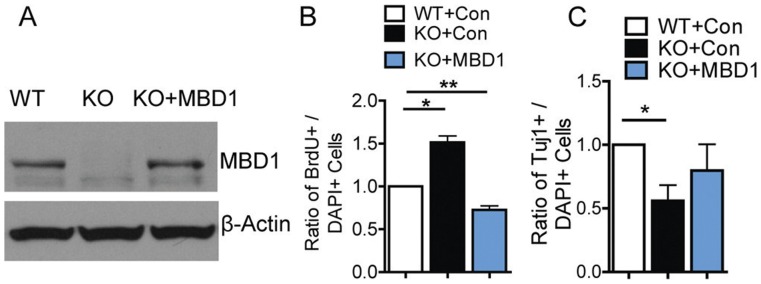
MBD1 rescues aNSC deficits associated with MBD1 deficiency.(A) Infection by lenti-MBD1 virus could restore MBD1 expression in Mbd1 KO aNSCs to levels similar to WT aNSCs. (B) Exogenous MBD1 rescued proliferation deficits exhibited by Mbd1 KO aNSCs (n = 4). (C) Exogenous MBD1 could rescue neuronal differentiation deficits exhibited by Mbd1 KO aNSCs as assessed by quantification of Tuj1-positive cells (C, n = 4, p<0.05). Data are presented as mean ± SEM; statistics were done using one-sample t-test*, p<0.05, **, p<0.01.